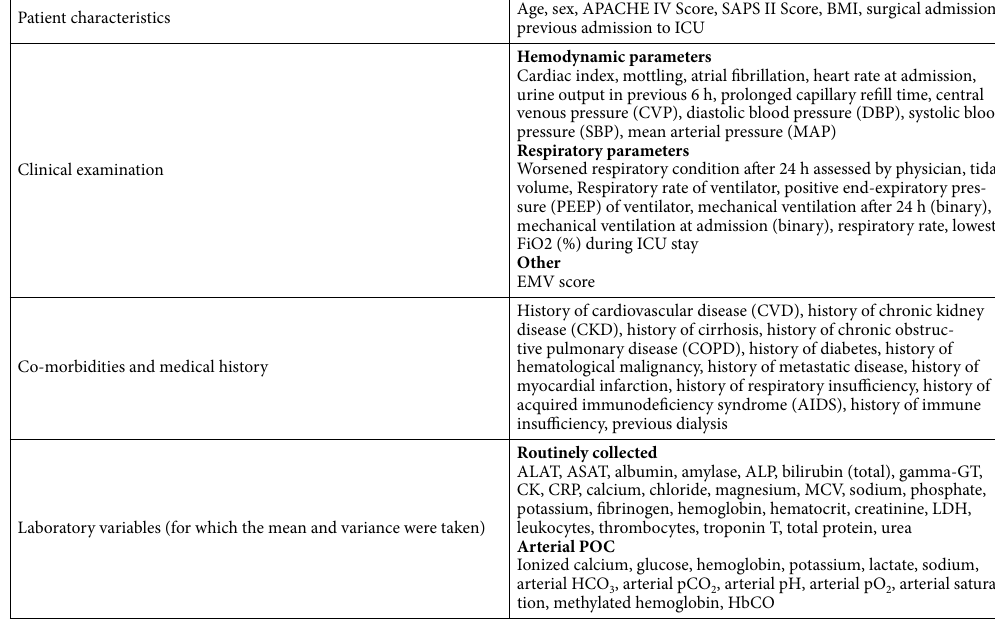
Table 1. Complete list of input features. List including all patient characteristics, co-morbidities, time-series of laboratory parameters, and clinical examination parameters. ALAT alanine transaminase, ASAT aspartate transaminase, CK creatine kinase, CRP C-reactive protein, LDH lactate dehydrogenase, POC point of care,